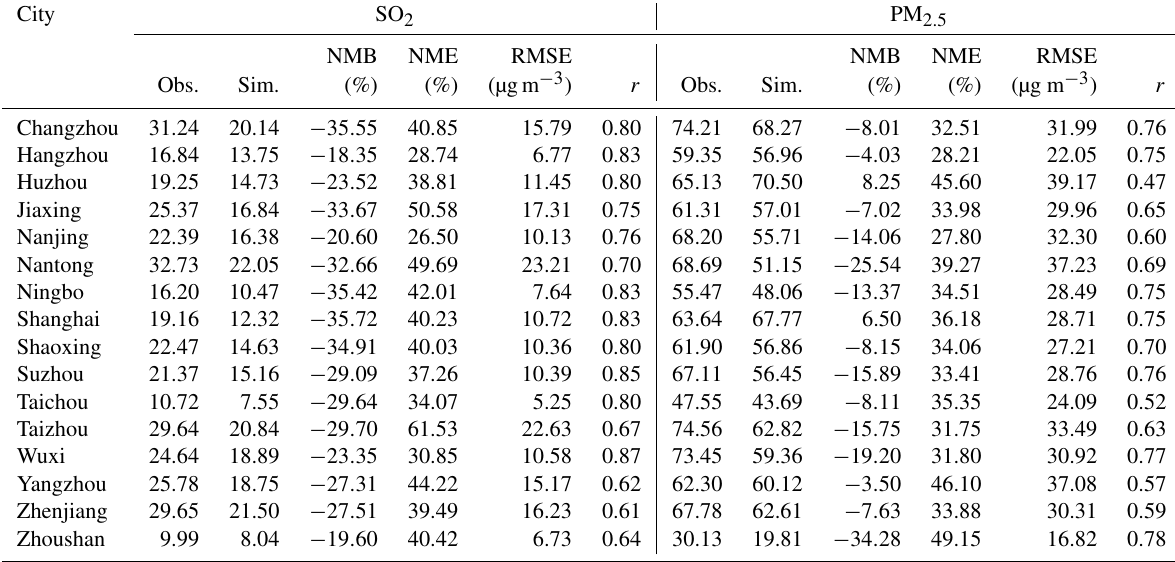
Table 1. Statistical metrics of the model evaluation. Observed data (Obs.) and simulated data (Sim.) for each city are the average of monthly values of January and June case. NMB (normalized mean bias), NME (normalized mean error), RMSE (root mean-square error) and r (the Pearson correlation coefficient) were calculated based on the daily average observed and simulated